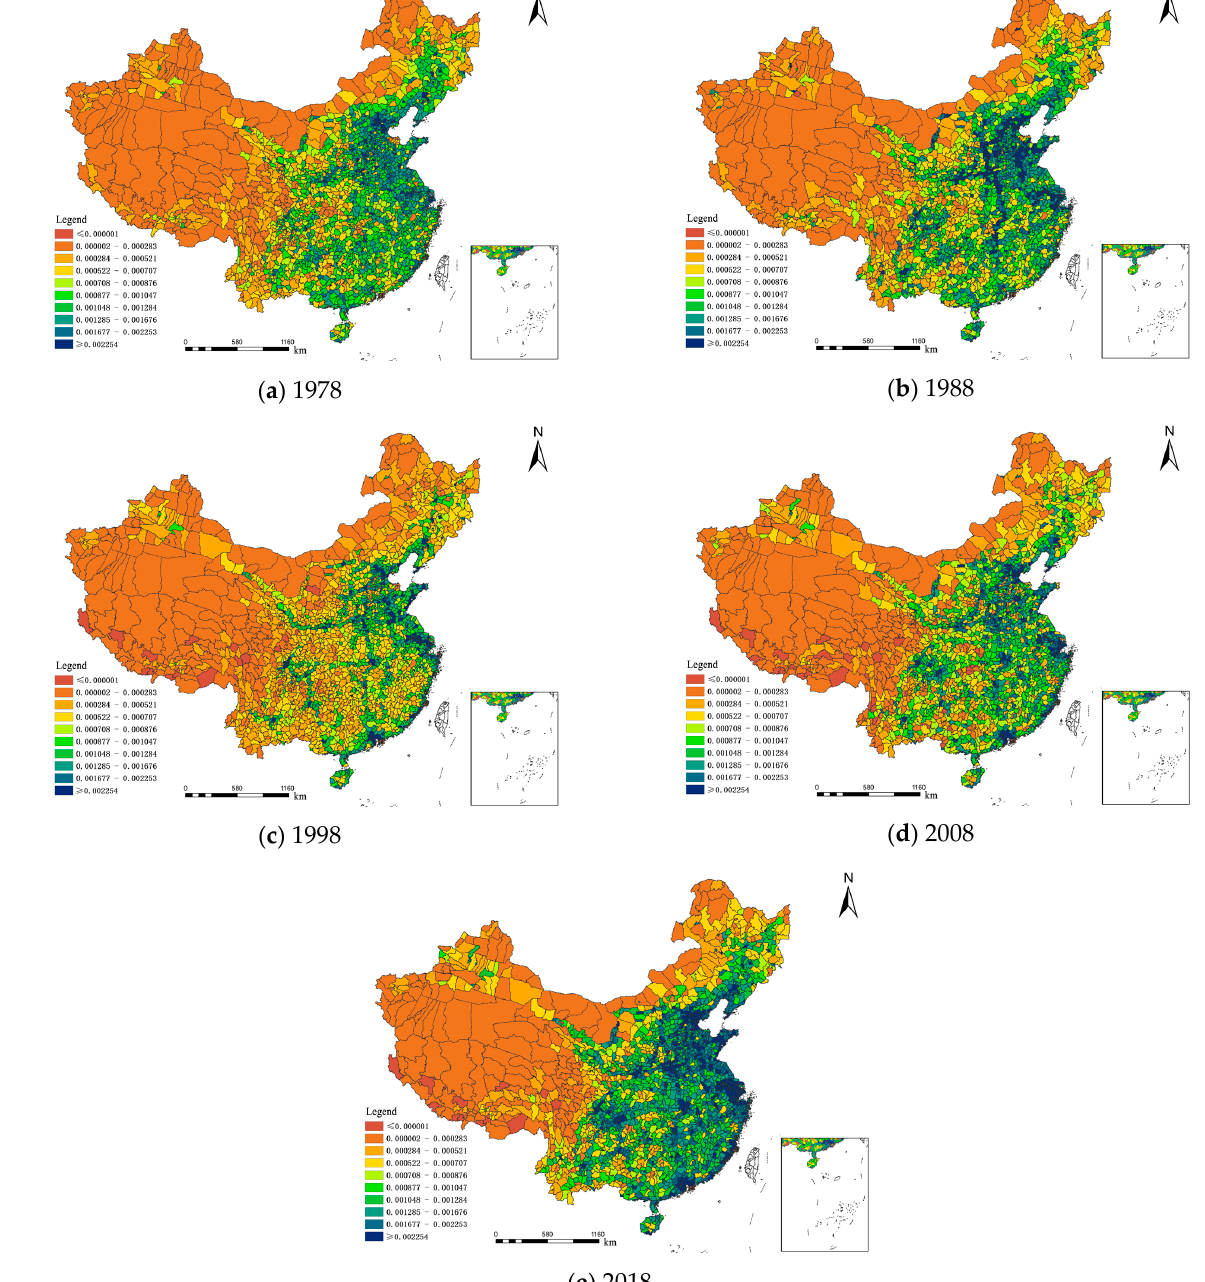
Figure 2. The land used for transportation at the county level in China from 1978 to 2018.